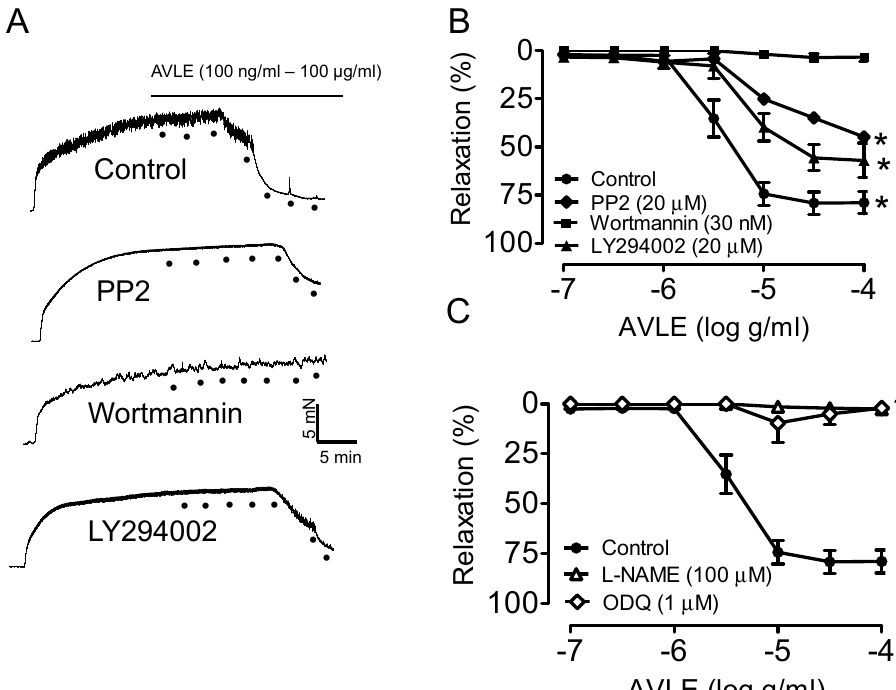
Figure 1. AVLE concentration-dependently (100 ng/mL–100 µg/mL) induced relaxation in isolated rat aortas. ( A , B ) Representative traces and graph showing the relaxation induced by AVLE was markedly decreased by inhibitor of Src kinase (PP2, 20 µM); and PI3-Kinase inhibitors (wortmannin, 30 nM and LY294002, 20 µM) ( C ) while eNOS inhibitor (L-NAME, 100 μ M,) and soluble guanylate cyclase inhibitor (ODQ, 1 μ M) abolished the relaxation response by AVLE. Results are means ± SEM ( n = 5–6). * p < 0.05 compared to control.